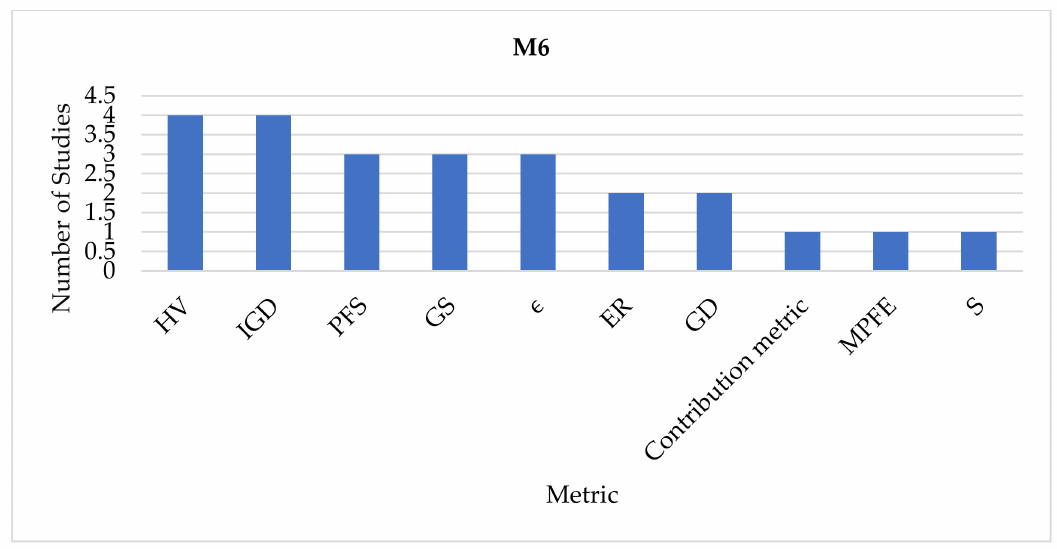
Figure 9. Metrics distribution in M6 group.